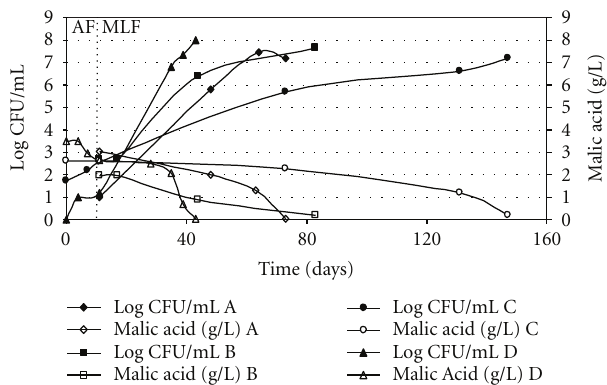
Figure 2: Viable LAB population and L-malic acid concentration in